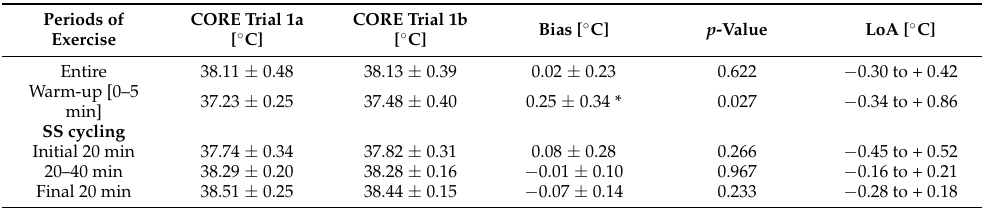
Table 1. Mean core body temperatures as measured with the CORE sensor during Trials 1a (first column) and 1b (second column) for the entire period of exercise, the 5-min warm-up, and 20-min intervals of the steady-state (SS) exercise. In addition, the third and fifth columns document the mean bias and limits of agreement (LoA), respectively.